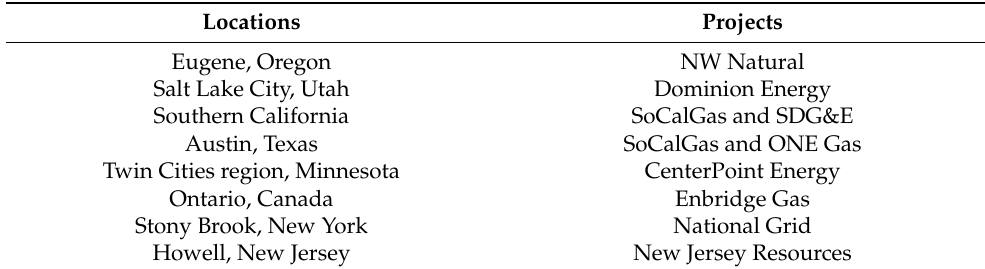
Table 4. North American gas utilities hydrogen projects